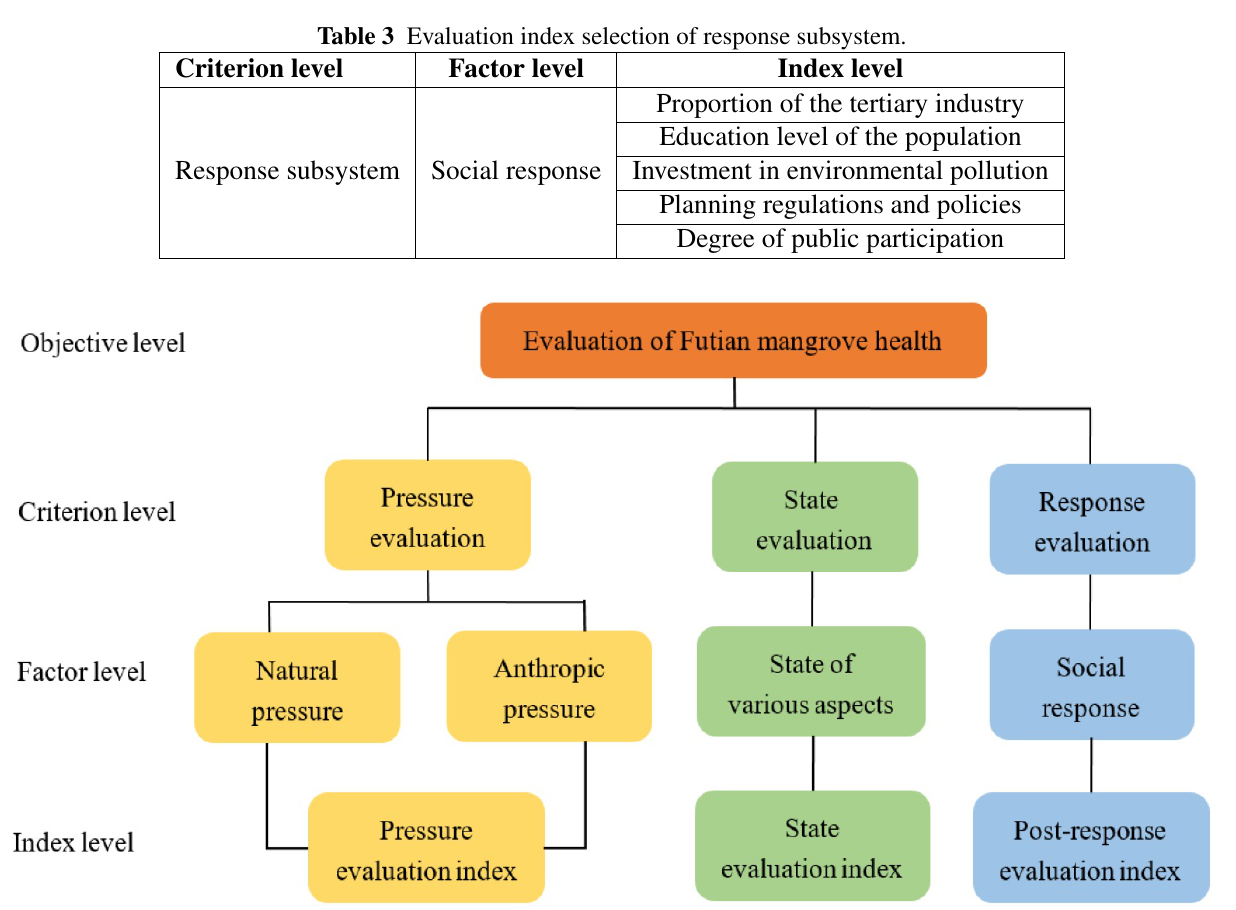
Table 3 Evaluation index selection of response subsystem.